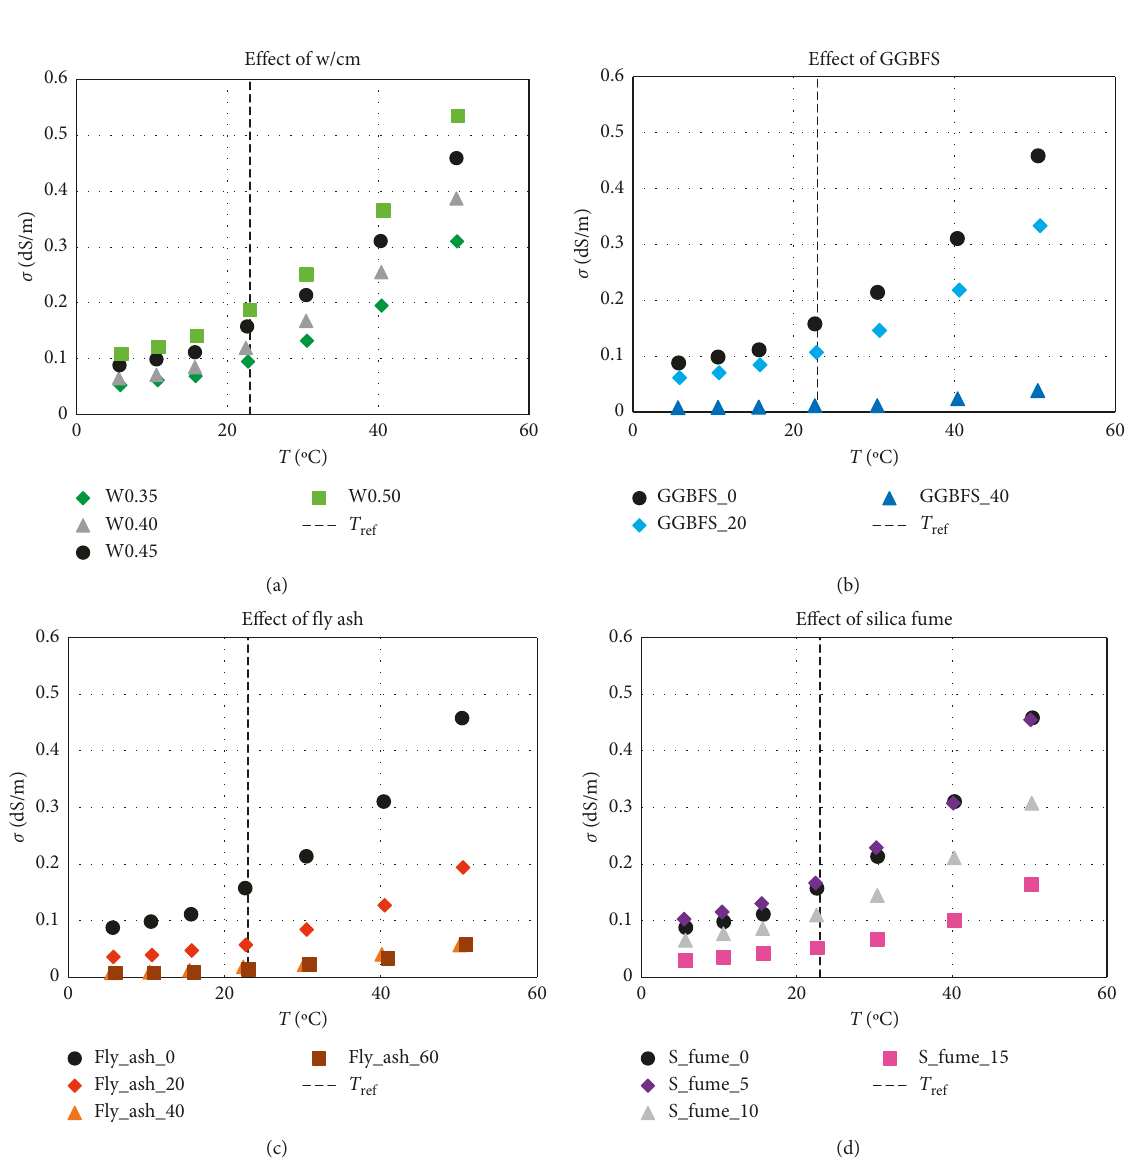
Figure 2: Changes in σ with T for mixes varying in (a) w/cm, (b) GGBFS, (c) fly ash, and (d) silica